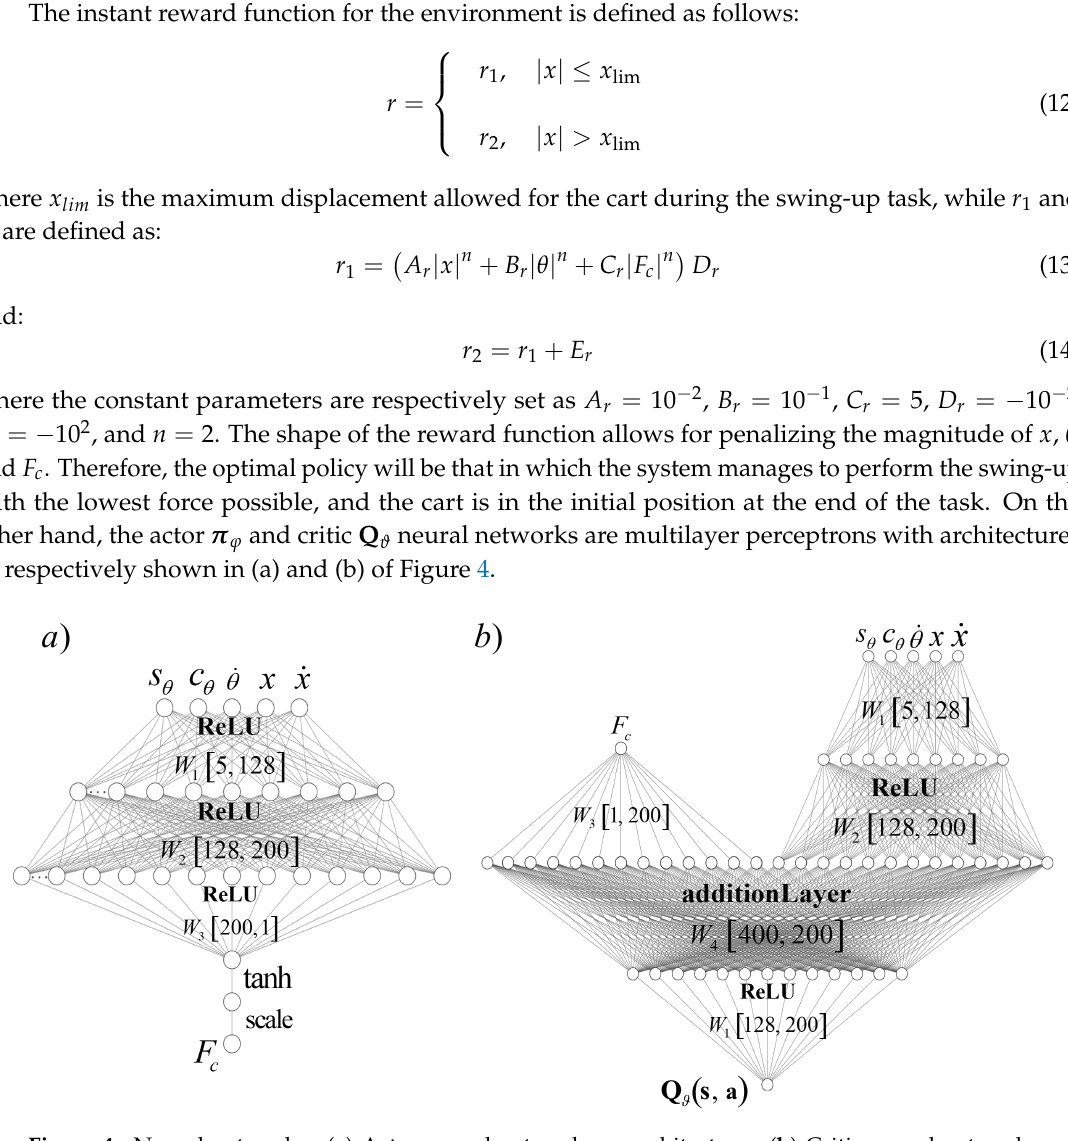
Figure 4. Neural networks. ( a ) Actor neural network πππ ϕ architecture. ( b ) Critic neural network Q ϑ